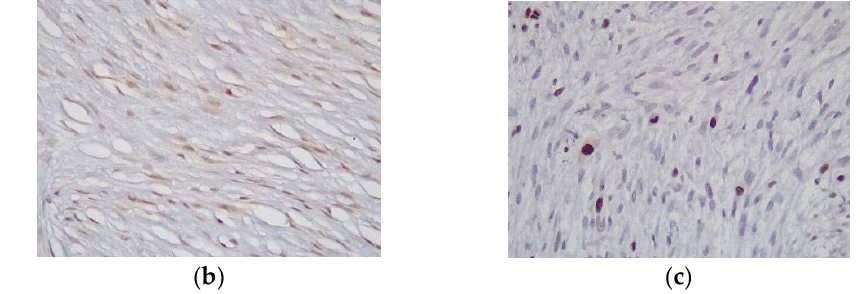
Figure 2. Horse, sarcoid. Immunohistochemistry for ( a ) pRb antibody showing strong nuclear positivity in neoplastic fibroblasts (score 1) (Ob.200×) ( b ) Cyclin D1 showing moderate nuclear positivity in the majority of neoplastic cells (score 3) (Ob.100×) ( c ) Ki-67 showing a minority of cells with nuclear positivity (Ob.200×).